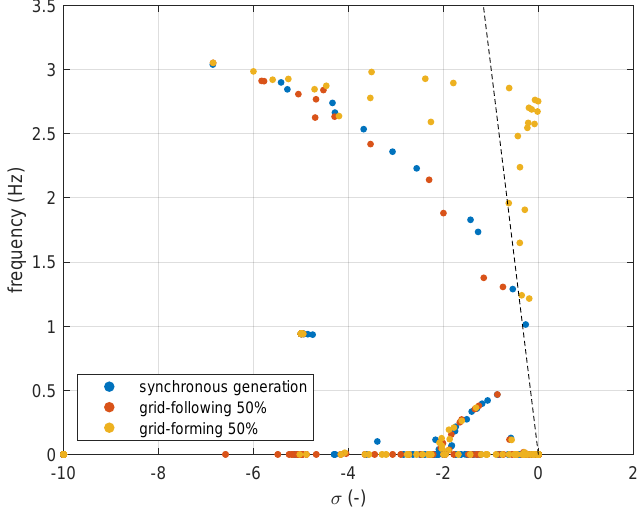
Figure 15. Eigenvalues of the Colombian power system. The Colombian system is next analysed with time-domain phasor simulations. The system is simulated for a sudden generation outage in Area 1. The results of the dynamic simulations are shown in Figures 16–18. For the considered disturbance, it is possible to observe that the system experiences both local and inter-area oscillations. The nodes closest to the location of the disturbance are significantly affected, with a severe rate of change of frequency and instantaneous frequency deviations, as expected. The system reaches a new steady-state condition after a series of transient power exchanges between generation sources. In the case of 50% grid-following with synthetic inertia, the system shows improved damping capabilities, with limited oscillations during the transient, and also a better coherency between the different areas. In comparison with the reference case of all synchronous generation, it can be noticed that the integration of grid-following generation sources reduces both the power-frequency swings related to local modes and the oscillations associated to the inter-area modes of the system (Figure 17), even if the power converters are delivering synthetic inertia. The impact on the oscillatory behaviour of the system is therefore beneficial. In the case of 50% grid-forming, the dynamic behaviour of the system is instead clearly affected by prolonged oscillations in the low-frequency region, associated with an intense exchange of active power between the generation sources during the transient. In this case, the integration of grid-forming generation sources determines an increase of the power-frequency swings in the system, especially from the point of view of the inter-area modes (Figure 18). In comparison with the reference